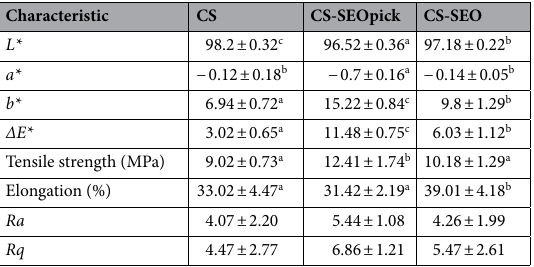
Fig. 7b. There were two slight cavity-like structures found (indicated by yellow arrows), which were probably caused by the sample preparation procedure. The incorporation of SEO resulted in an amorphous structure, with vacuoles and pores distributed along the cross-section surface of CS-SEOpick and CS-SEO. Notably, the disper- sion of SEO developed with Pickering emulsion caused a decrease in the discontinuities and droplet size and an increase the droplet distribution in the cross-sections of films, as indicated with a yellow circle.